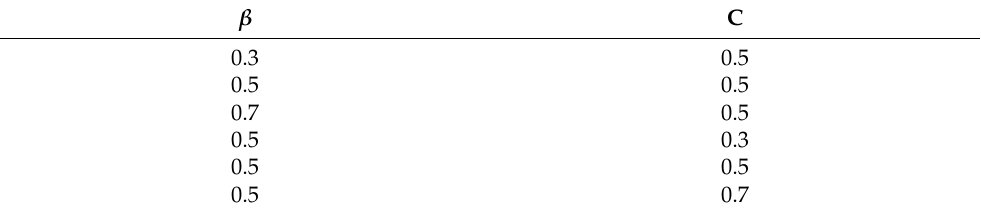
Table 3. Values for beta and